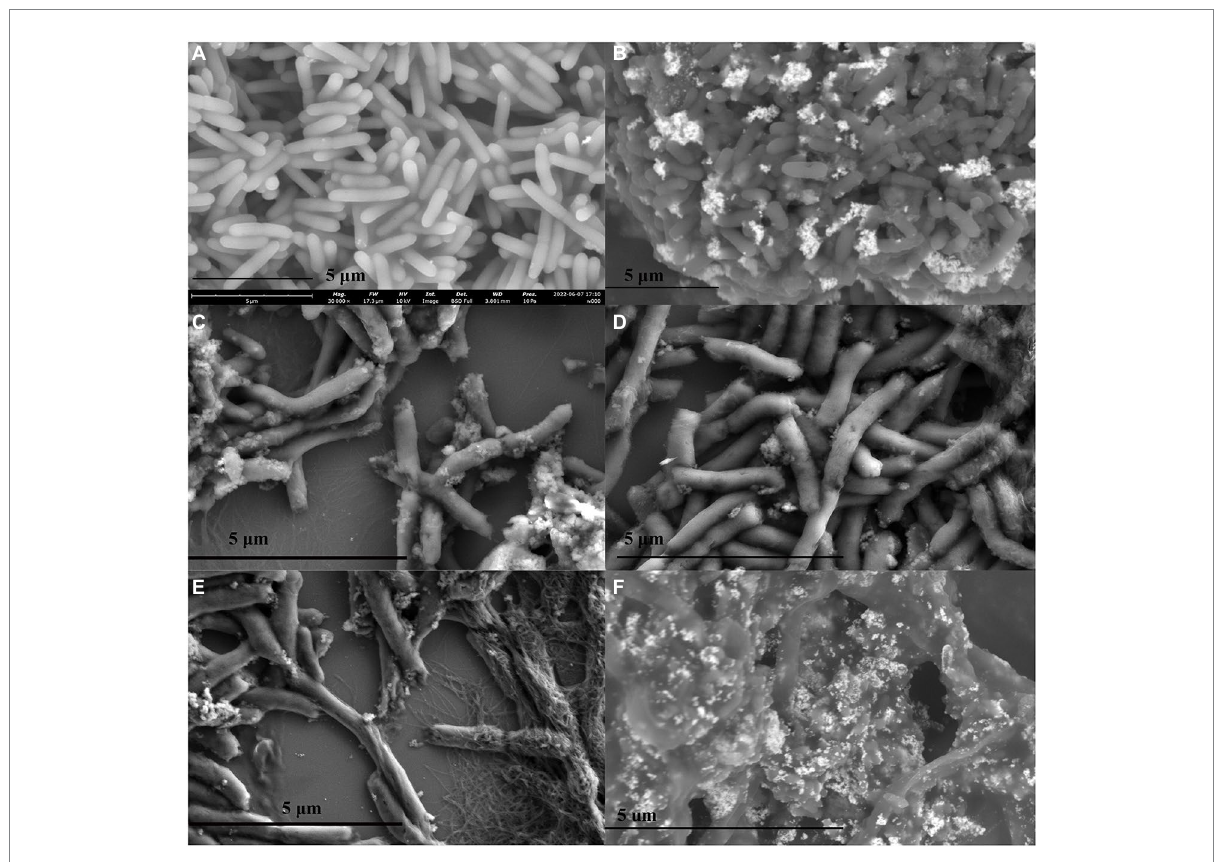
FIGURE 8 SEM images of cells treated with different concentrations of Mf-AgNP. (A–F) denote the images from cells treated with AgNP at 1MIC concentration for 0, 15, 30 min, 1 and 2 h, respectively. The panel (F) illustrated several cells that underwent severe structure abnormalities when treated for 2